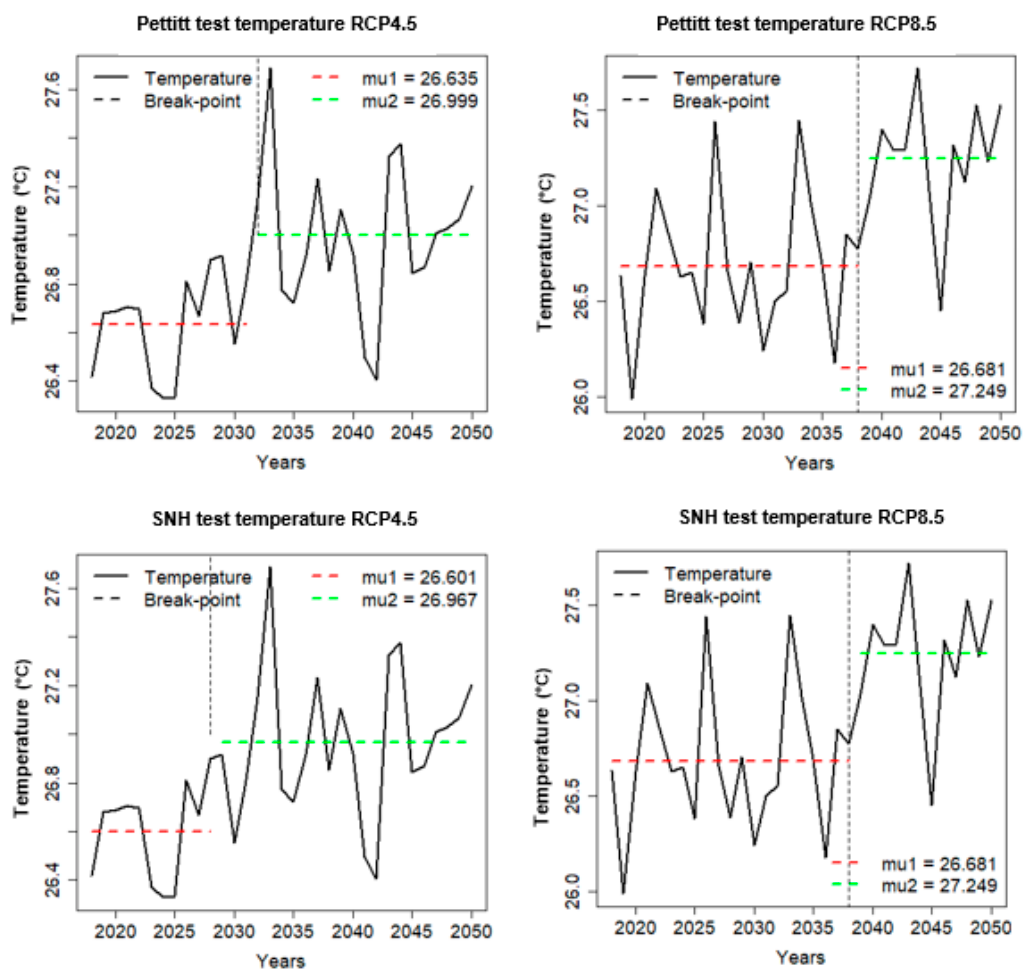
Figure 10. Pettitt test ( upper panel ) and SNH test ( lower panel ) performed on temperature under RCP4.5 and RCP8.5.